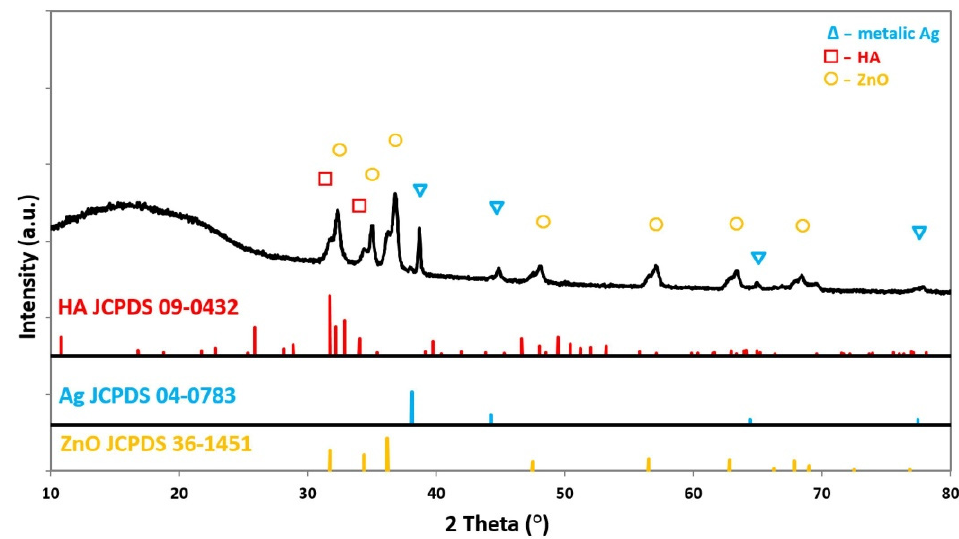
Figure 6. X ‐ ray diffraction patterns of the PDLLA/PLGA/nHA/nZnO:Ag sample correlated with JCPDS data for HA, Ag, and ZnO.